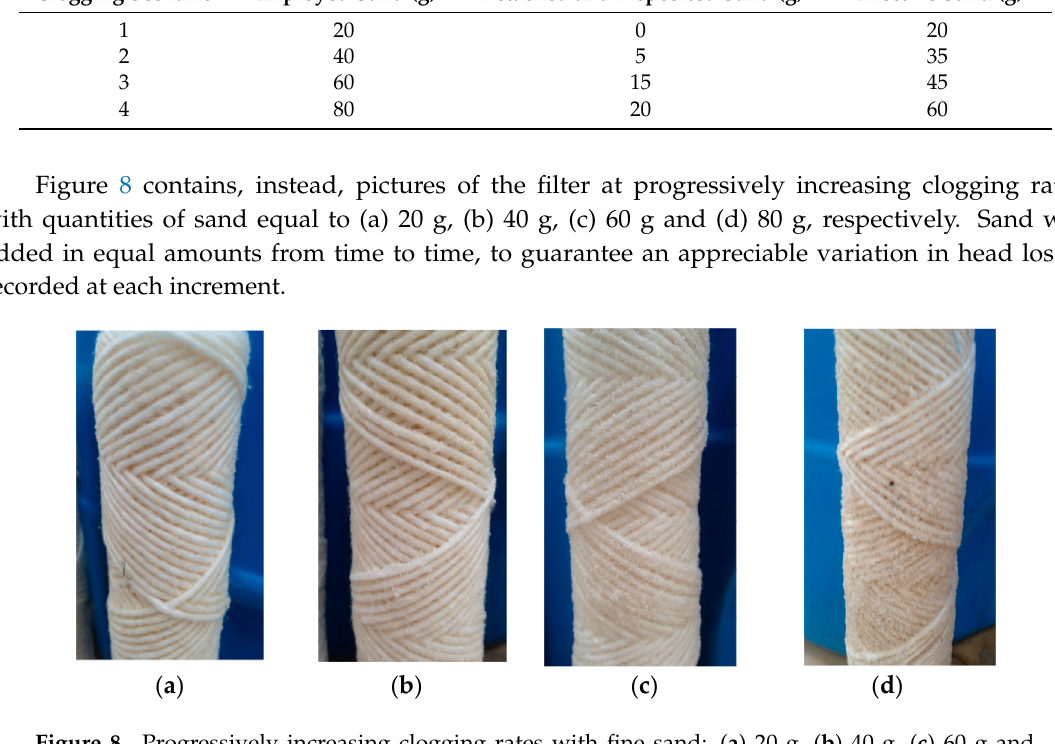
Figure 8. Progressively increasing clogging rates with fine sand: ( a ) 20 g, ( b ) 40 g, ( c ) 60 g and ( d ) 80 g, respectively.